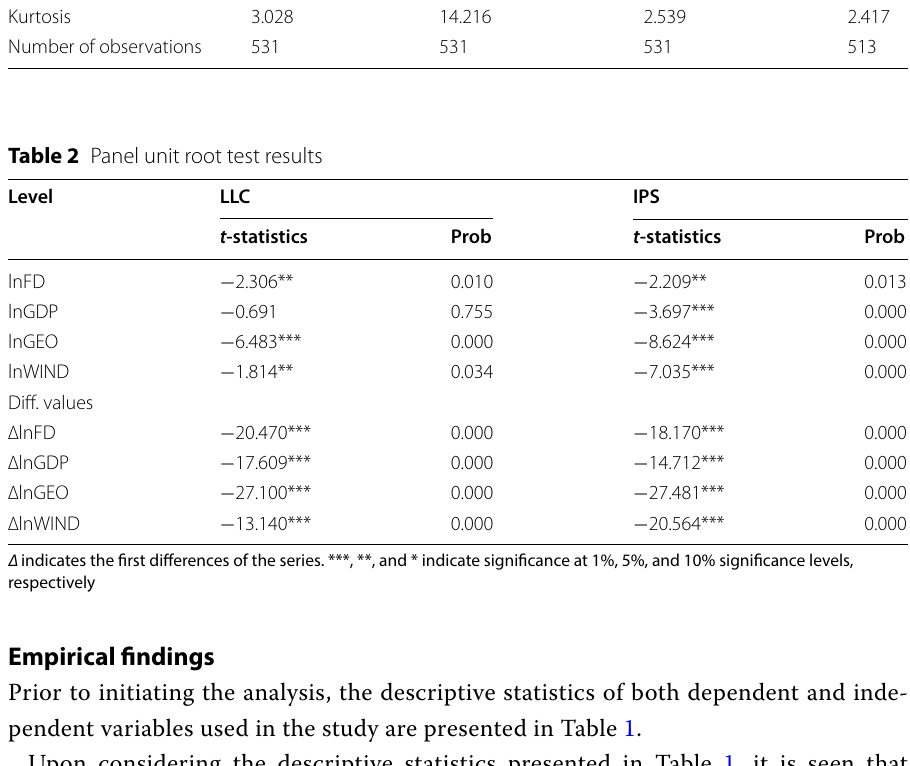
Table 2 Panel unit root test results